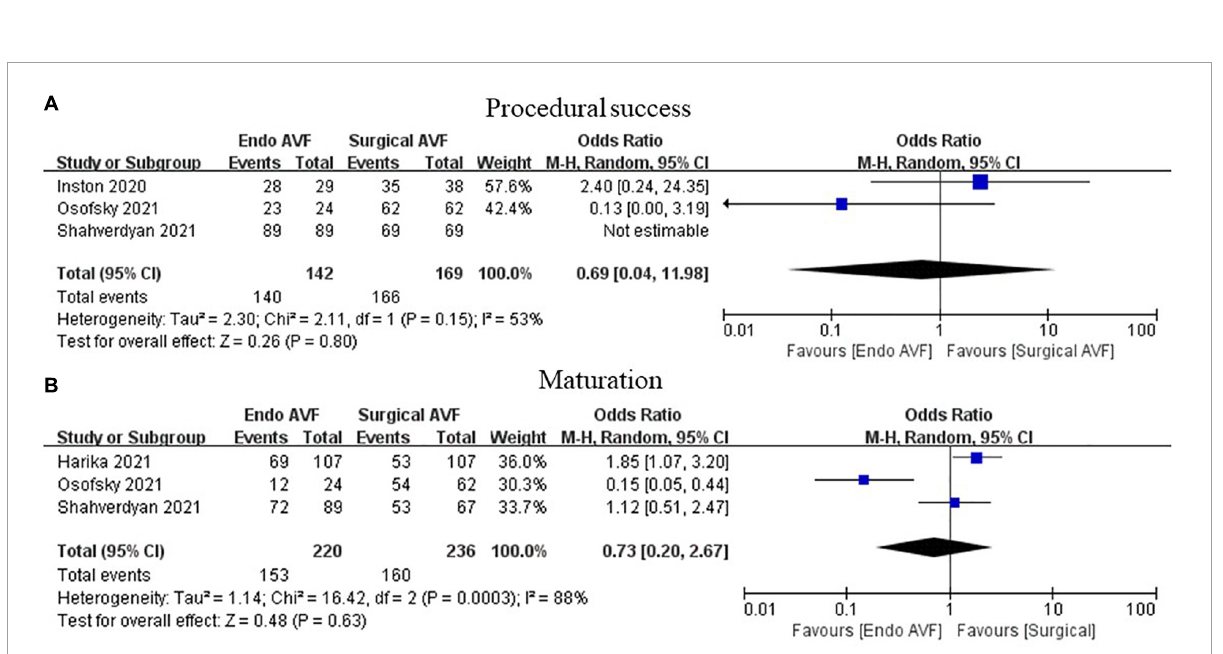
FIGURE3 Meta-analysis of procedural success and maturation. (A) Above we have marked procedural success and (B) marked maturation. AVF, arteriovenous fistula; M-H,